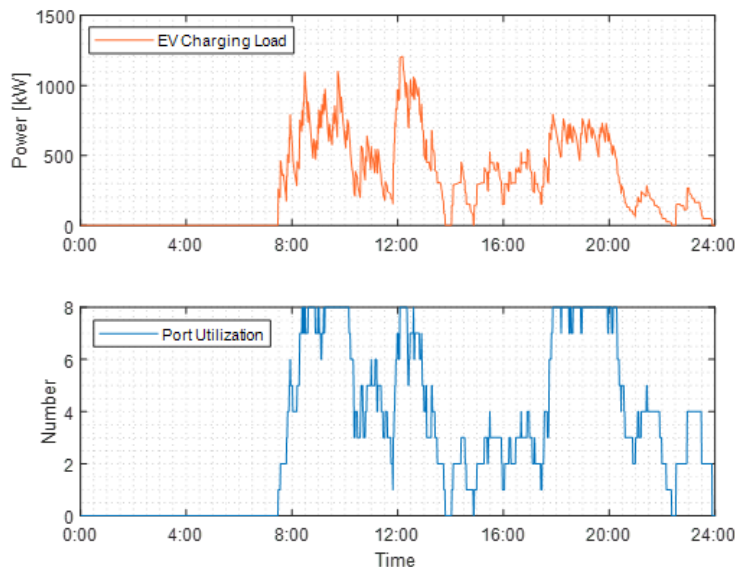
Figure 9. EV charging load and port utilization of XFC8.